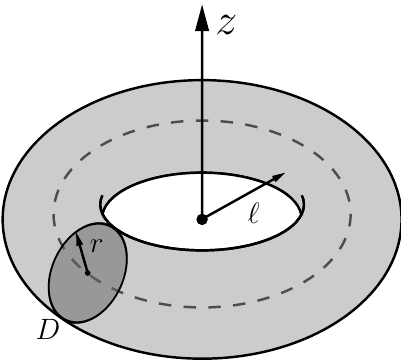
Figure 3. A ring formed by the revolution around the z axis of a disk D of radius r , such that the inner radius of the ring is l